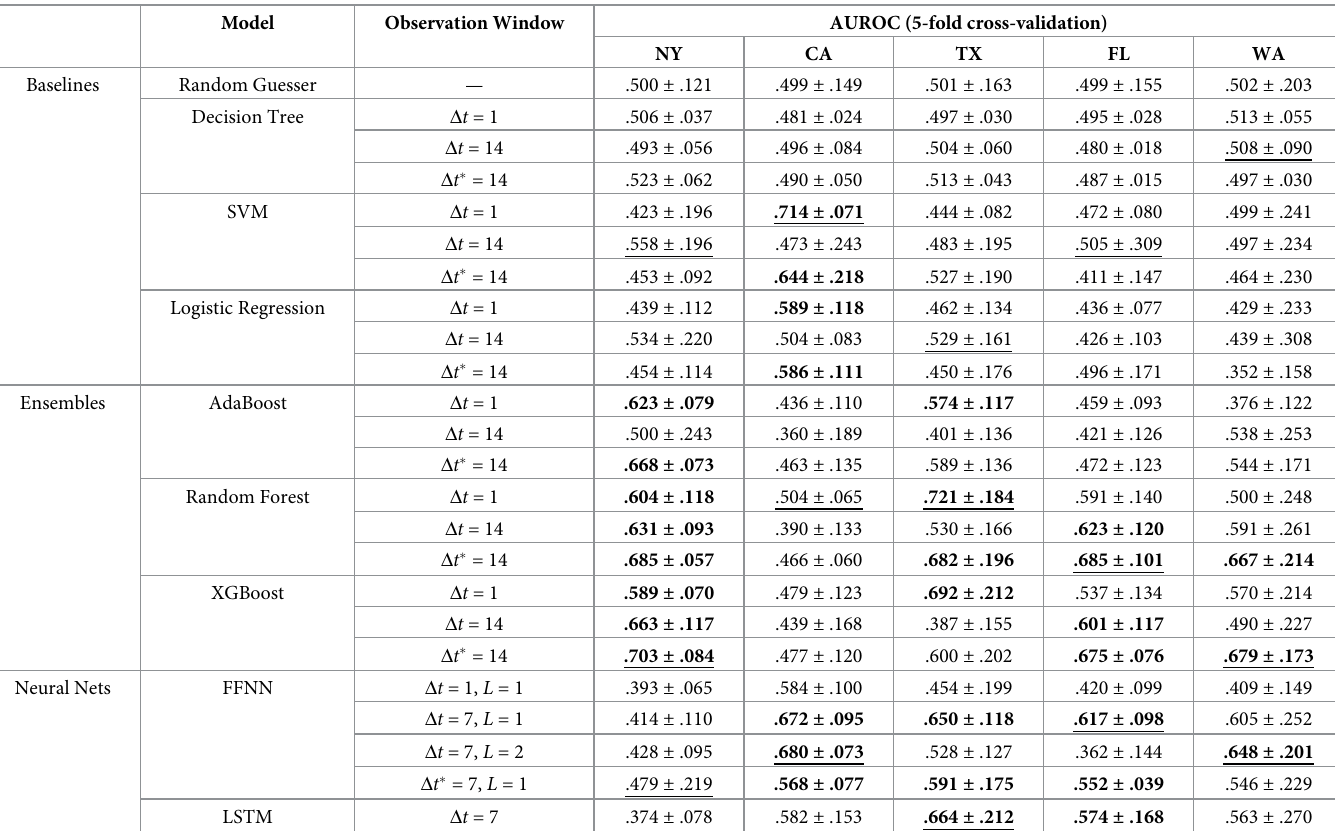
Table 3. Summary of classification